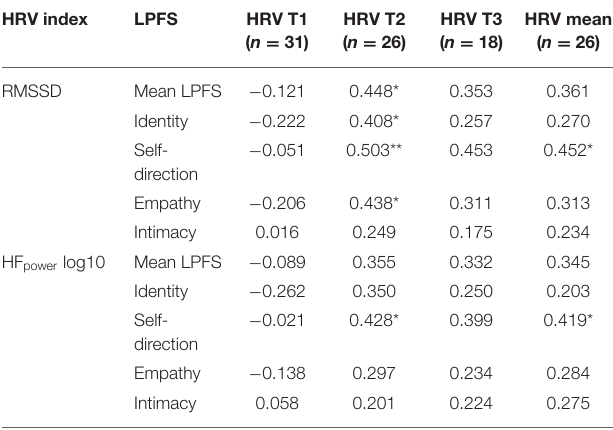
TABLE 1 | Descriptive statistics.